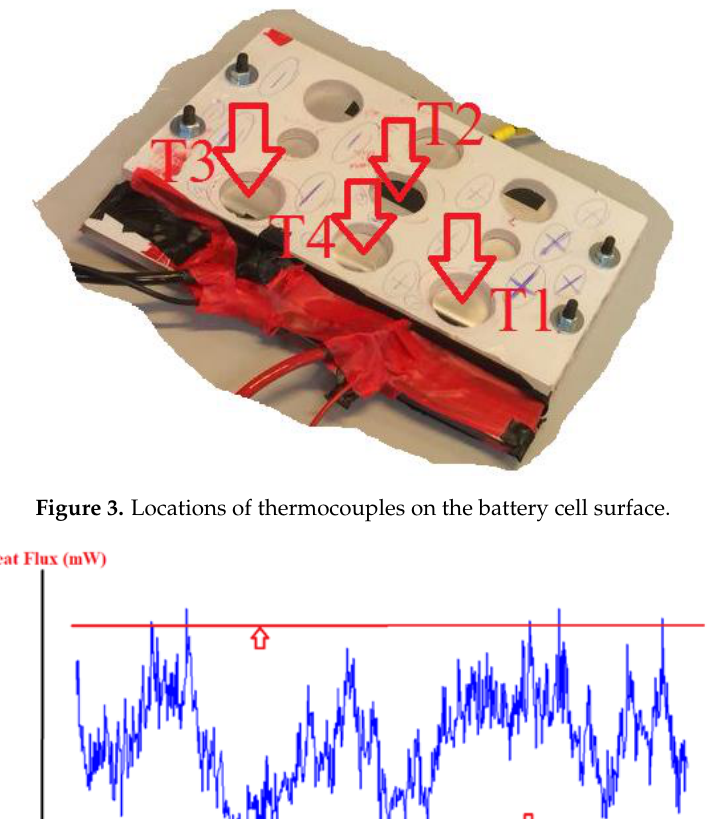
Figure 2. Experimental setup. ( a ) Isothermal battery calorimeter; ( b ) Maccor automated test system.